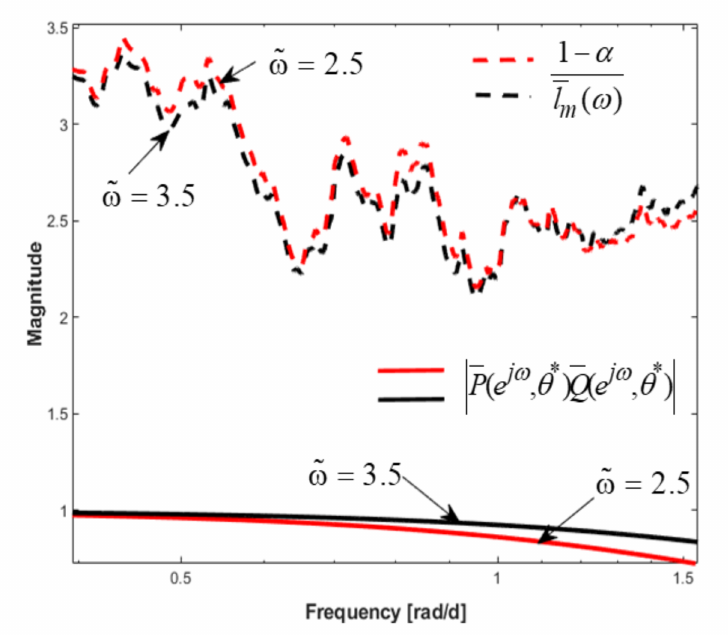
Figure 21. Analysis of the robust stability margin for (cid:101) ω = 2.5 [ rad/d ] and (cid:101) ω = 3.5 [ rad/d ] . (3) The effect of a measurement noise with the standard deviation σ n = 0.233 on the controlled variable was tested. Under these conditions, the standard deviation of the controlled variable is σ COD = 0.0233, and the evolution of this variable is given in Figure 22.